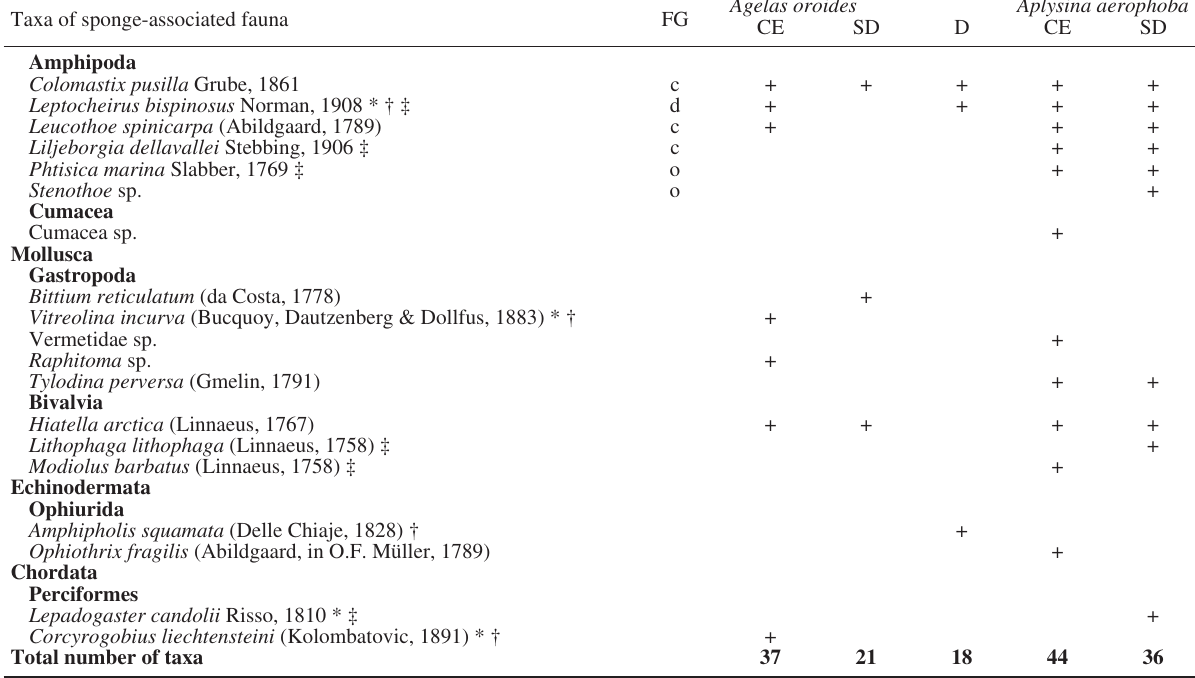
Table 2. – Taxa of symbionts per taxonomic group for the sponges Agelas oroides and Aplysina aerophoba in the studied caves (CE, entrance; SD, semidark zone; D, dark zone). Both